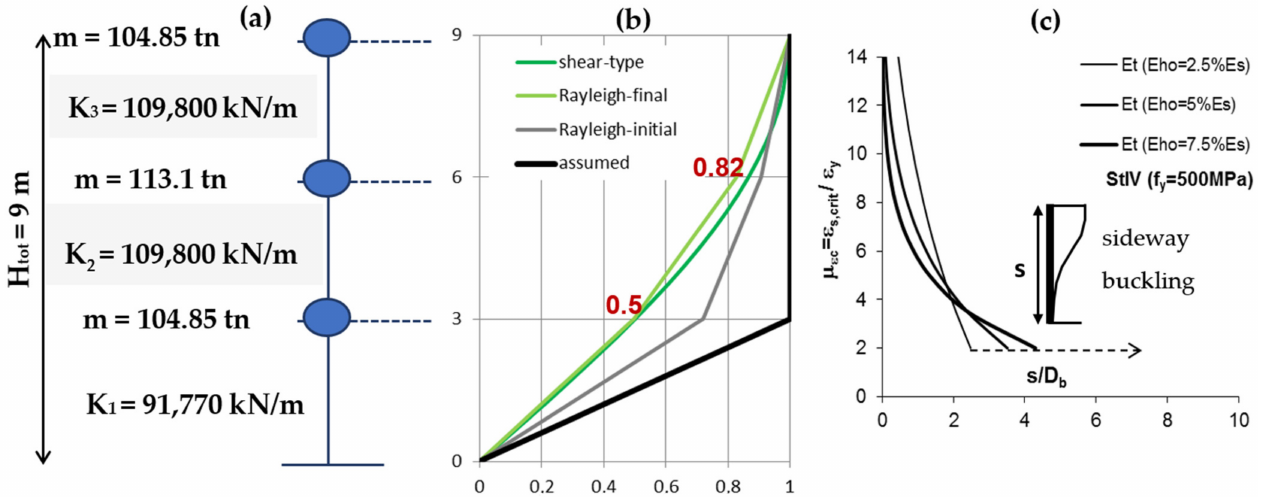
Figure 5. ( a ) Stiffness distribution of the enhanced building and ( b ) its lateral displacement profile after performing Rayleigh iterative method. ( c ) Compressive strain ductility µ ε c versus stirrup spacing s/D b for